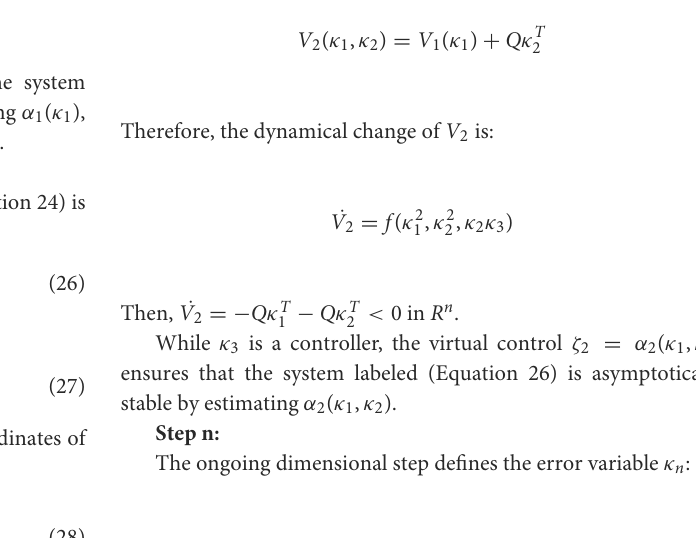
V 1 f ( κ 2 , κ 1 κ 2 ) 1 ˙ =